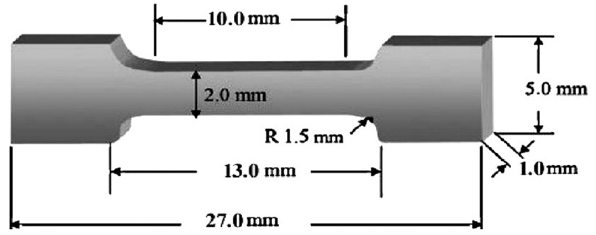
Figure 4: Dimension of the tensile test specimen.